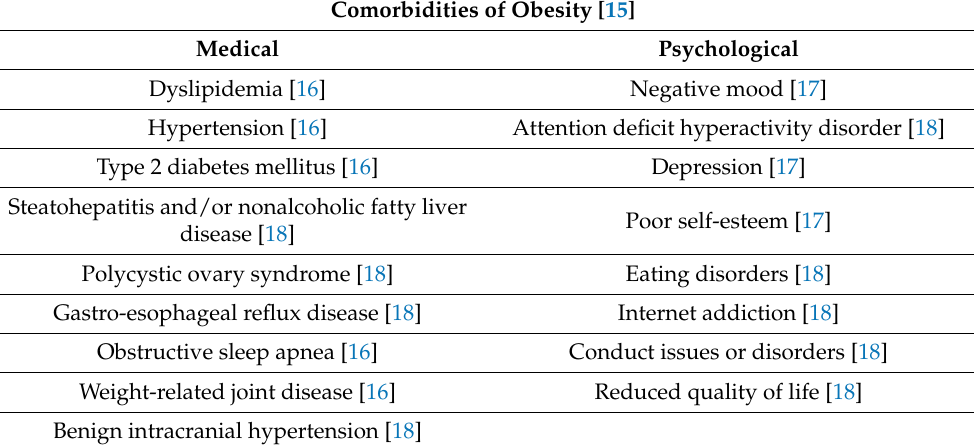
Table 2. Comorbidities of